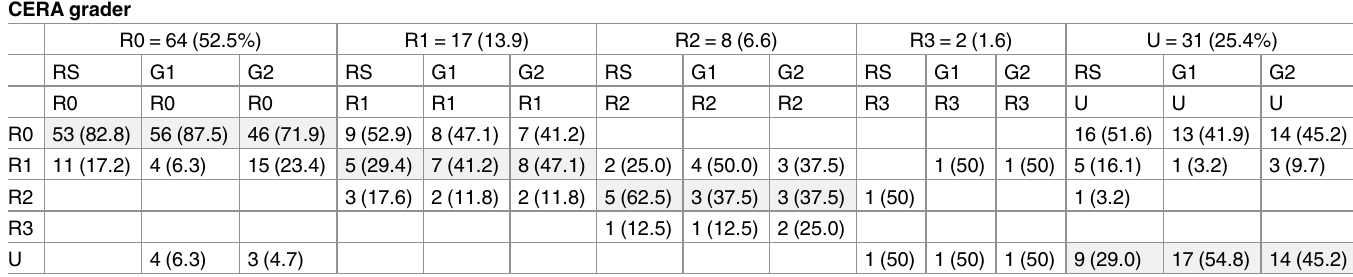
Table 2. Comparison of diabetic retinopathy graded by the CERA grader, retinal specialist and the local graders before training through the test set. CERA grader R0 = 64